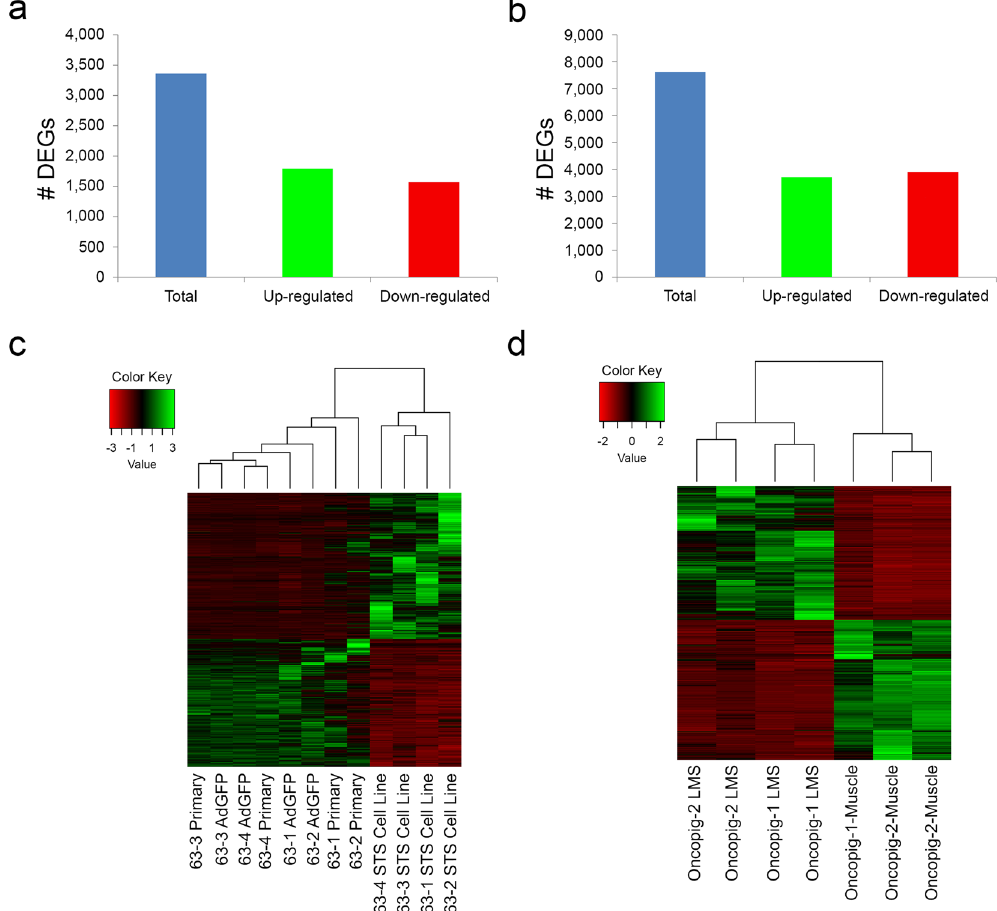
Figure 2. Total number of DEGs and their expression levels across biological replicates. Total number of DEGs, including those displaying elevated and reduced expression in ( a ) Oncopig STS cell lines compared to controls and ( b ) leiomyosarcoma tumors compared to controls. ( c ) Heatmap of the normalized expression level of the 3,360 DEGs for each cell line, represented as z-scores. ( d ) Heatmap of the normalized expression level of the 7,625 DEGs for each in vivo sample, represented as z-scores. LMS = leiomyosarcoma. Dendrograms represent relationships between samples based on complete linkage